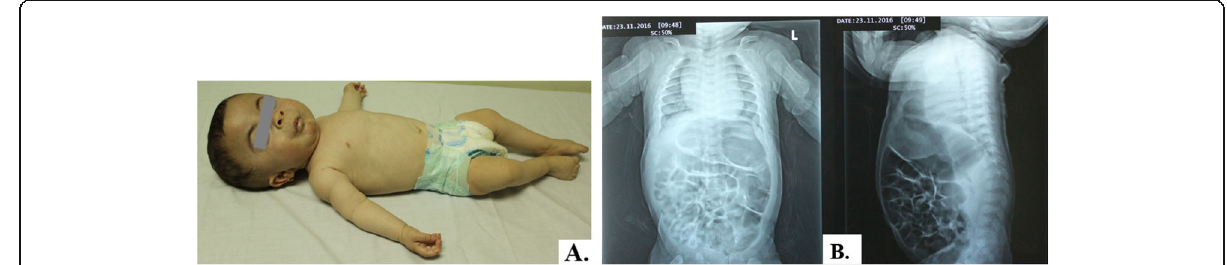
Fig. 4 Patient no. 6 at the age of 1 year. A Skeletal X-rays showing short humerus, horizontal oar-shaped ribs. B Lateral X-ray spine showing short biconvex vertebral bodies and oar-shaped ribs. Note high square forehead, short upturned nares, chest deformity, and short limbs